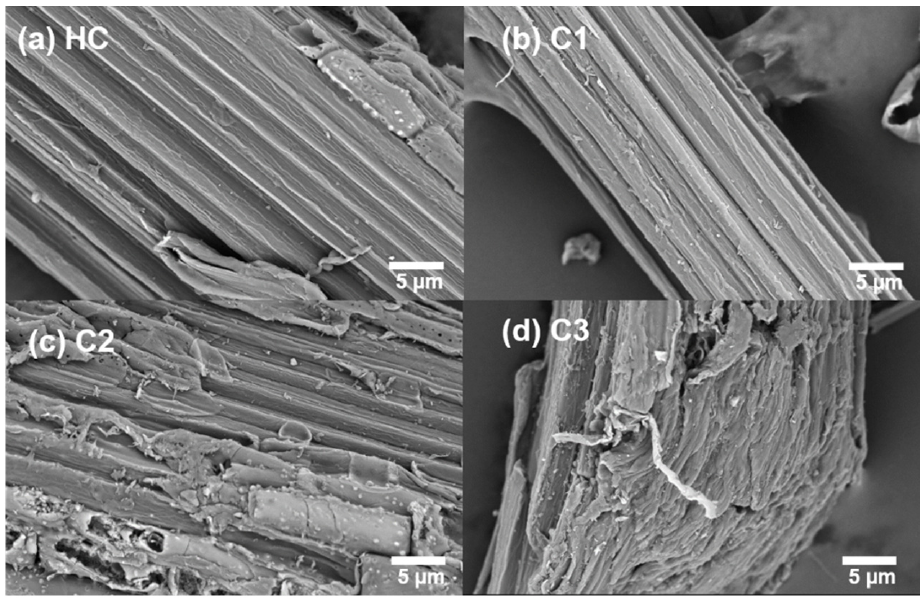
Figure 1. SEM images of the sample HC ( a ), C1 ( b ), C2 ( c ) and C3 ( d ) before and after HTP (Scale bar = 5 μ m).